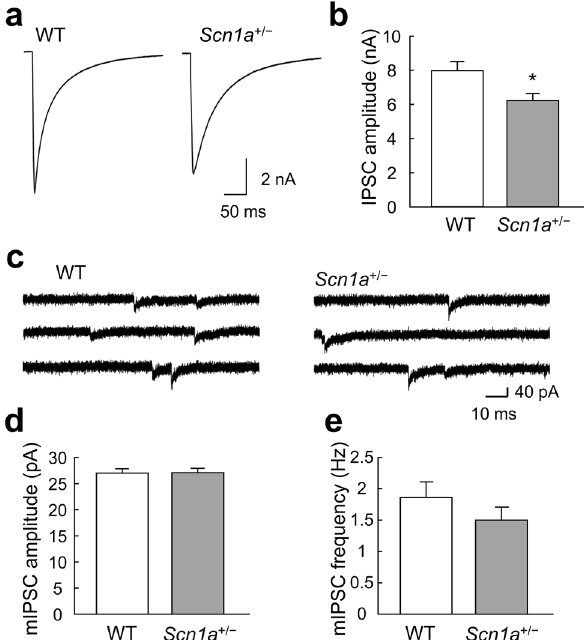
Figure 3. Changes in the inhibitory synaptic transmission of Scn1a +/− neurons. ( a ) Representative traces of evoked inhibitory postsynaptic currents (IPSCs) recorded from a single autaptic hippocampal neuron of either wild-type (WT) or Scn1a +/− mice. Depolarization artifacts caused by the generated action currents have been removed for clarity of presentation. ( b ) Average amplitudes of the evoked IPSCs in neurons of WT or Scn1a +/− mice (WT: 7.94 ± 0.55 nA, n = 96; Scn1a +/− : 6.18 ± 0.42 nA, n = 98/ N = 5 cultures, * p < 0.05). ( c ) Representative miniature IPSC (mIPSC) traces in neurons of either WT or Scn1a +/− mice. ( d ) Average mIPSC amplitudes in neurons of either WT or Scn1a +/− mice (WT: 26.94 ± 0.80 pA, n = 95; Scn1a +/− : 26.70 ± 0.86 pA, n = 96/ N = 5 cultures). ( e ) Average mIPSC frequencies in neurons of either WT or Scn1a +/− mice (WT: 1.85 ± 0.25 Hz, n = 95; Scn1a +/− : 1.50 ± 0.21 Hz, n = 96/ N = 5 cultures). Data were obtained from the same autaptic neurons as in ( d